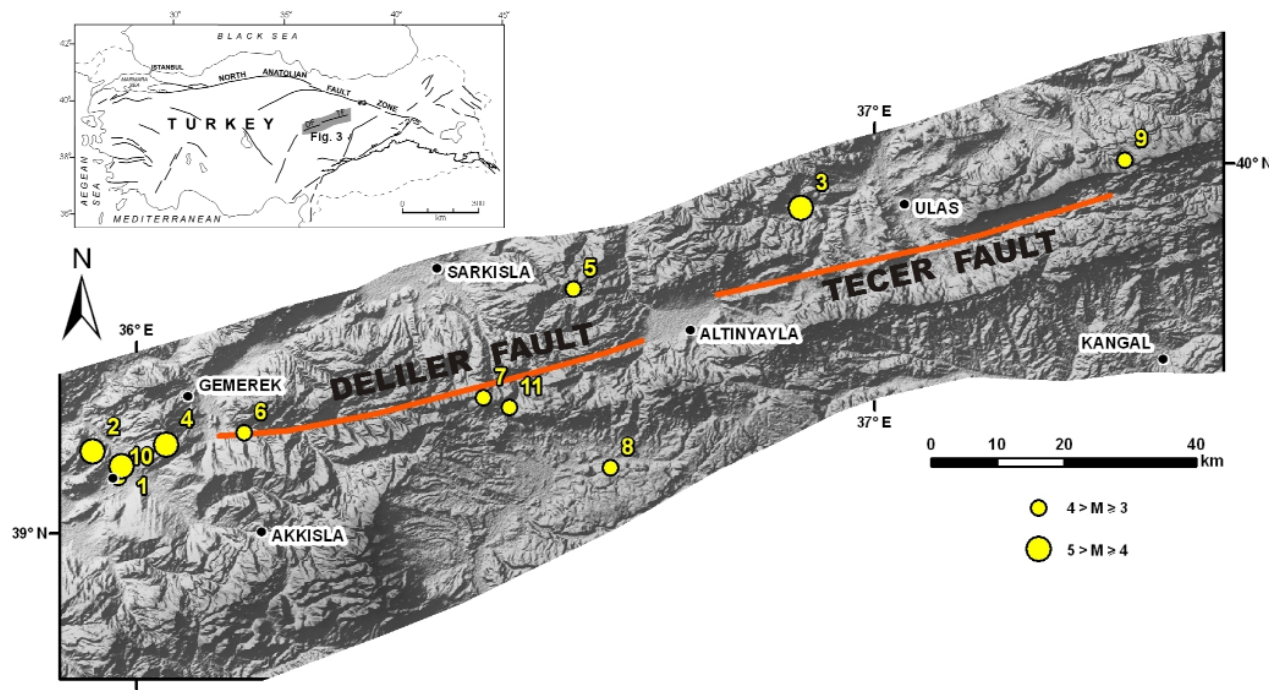
Figure 3. Seismicity around Deliler Fault and Tecer Fault over the last 50 years (Bogaziçi University Kandilli Observatory and Earthquake Research Institute; http://www.koeri.boun.edu.tr/sismo/ default.htm). The numbers correspond to the events listed in Table 1. Inset: location of relief map on Figure 1.